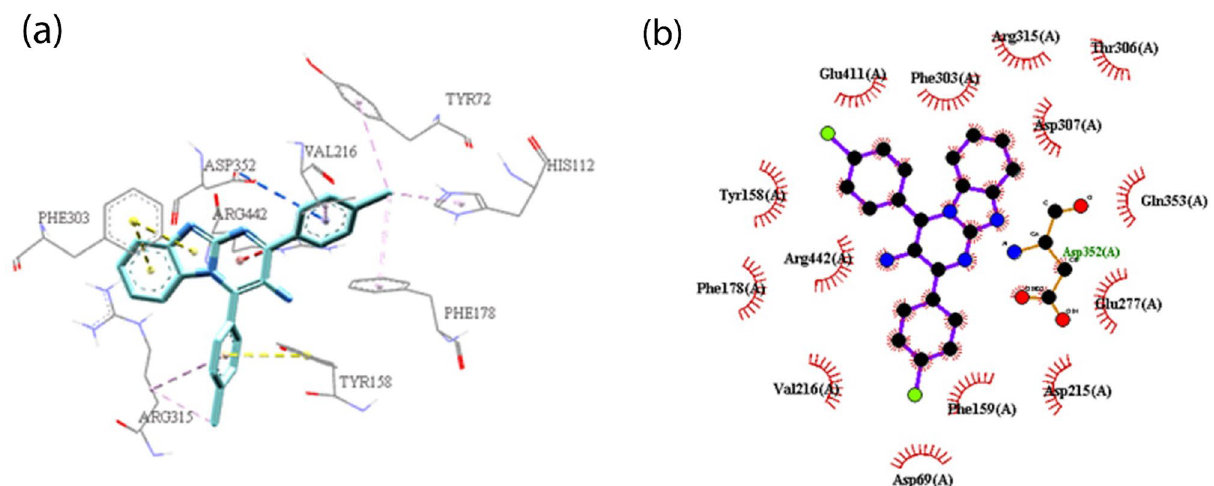
Figure 4. ( a ) The 3D and ( b ) 2D predicted binding mode of the compound 3k in the active site pocket (π–π: yellow, π-Anion: blue, π-cation: red, hydrophobic: pink). *This figure was created by using Discovery Studio 4.0 Client (https:// disco ver. 3ds. com/ disco very- studio- visua lizer- downl oad) and LigPlot (https:// www. ebi. ac. uk/ thorn ton- srv/ softw are/ LigPl us/ downl oad. html).